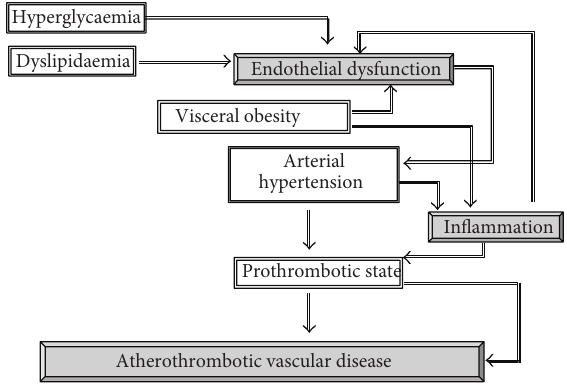
F 1: Potential mechanisms linking visceral obesity, which characterizes the metabolic syndrome, in�ammation, and athero- thrombotic vascular